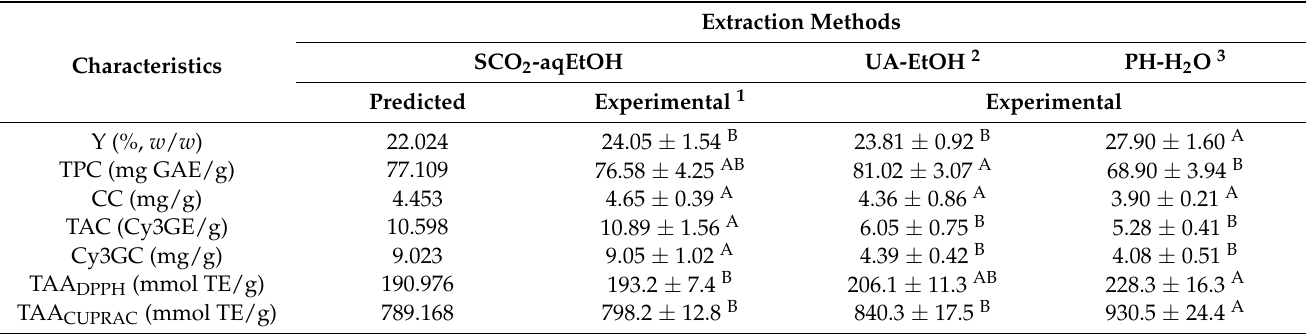
Table 2. Predicted and experimental values of the response variables at optimal conditions for SCO 2 and other extraction